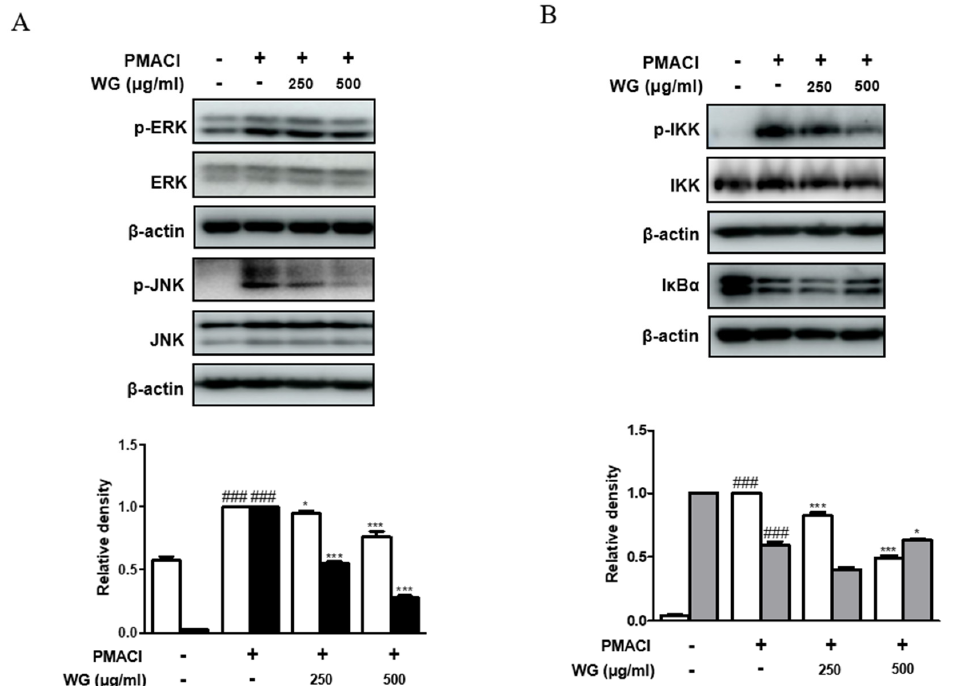
Figure 6. Effects of WG on PMACI ‐ induced activation of MAPKs and NF ‐κ B signaling pathway in PMACI ‐ stimulated HMC ‐ 1 cells. Western blot analysis was performed using total proteins and specific antibodies for ( A ) ERK, JNK, ( B ) IKK, and I κ B α . Here, β‐ actin was used to normalize protein expression levels. Densitometric analysis was performed using Bio ‐ Rad Quantity One ® Software. The data shown represent means ± S.D. of three independent experiments. Note: ### p < 0.001 vs. the control group; * p < 0.05, *** p < 0.001 vs. PMACI ‐ treated group.